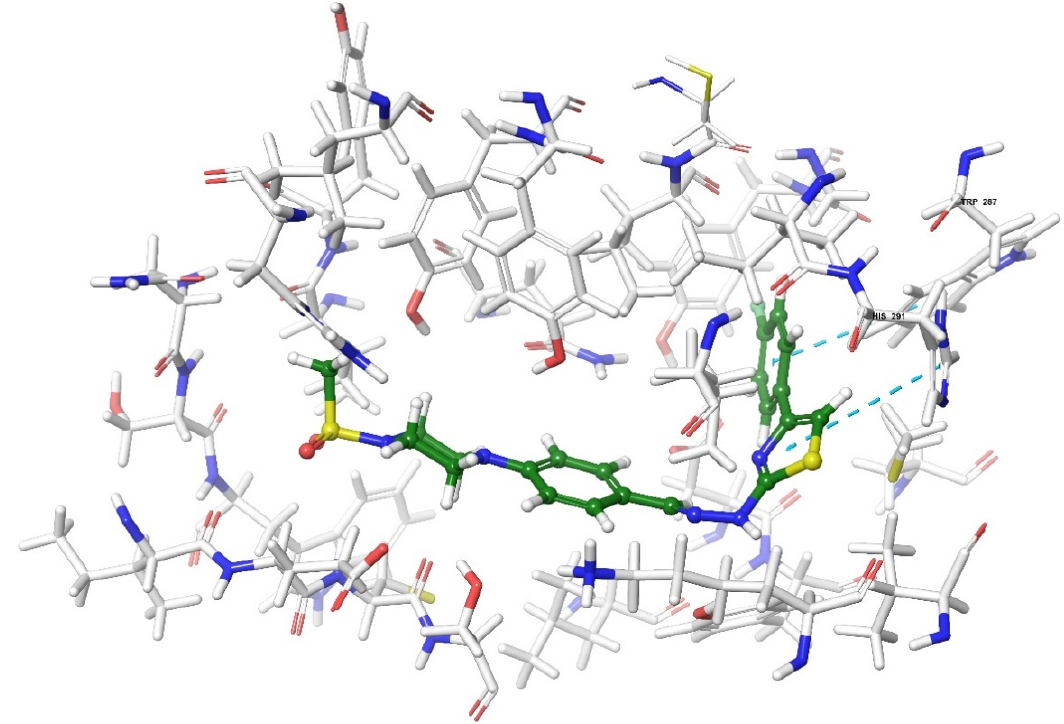
Figure 22. The three-dimensional interacting mode of compound 3f in the active region of k-opioid receptor. The ligand and significant residues of the active site of the receptor are presented by a tube model colored with green and white, respectively (PDB Code: 6B73).